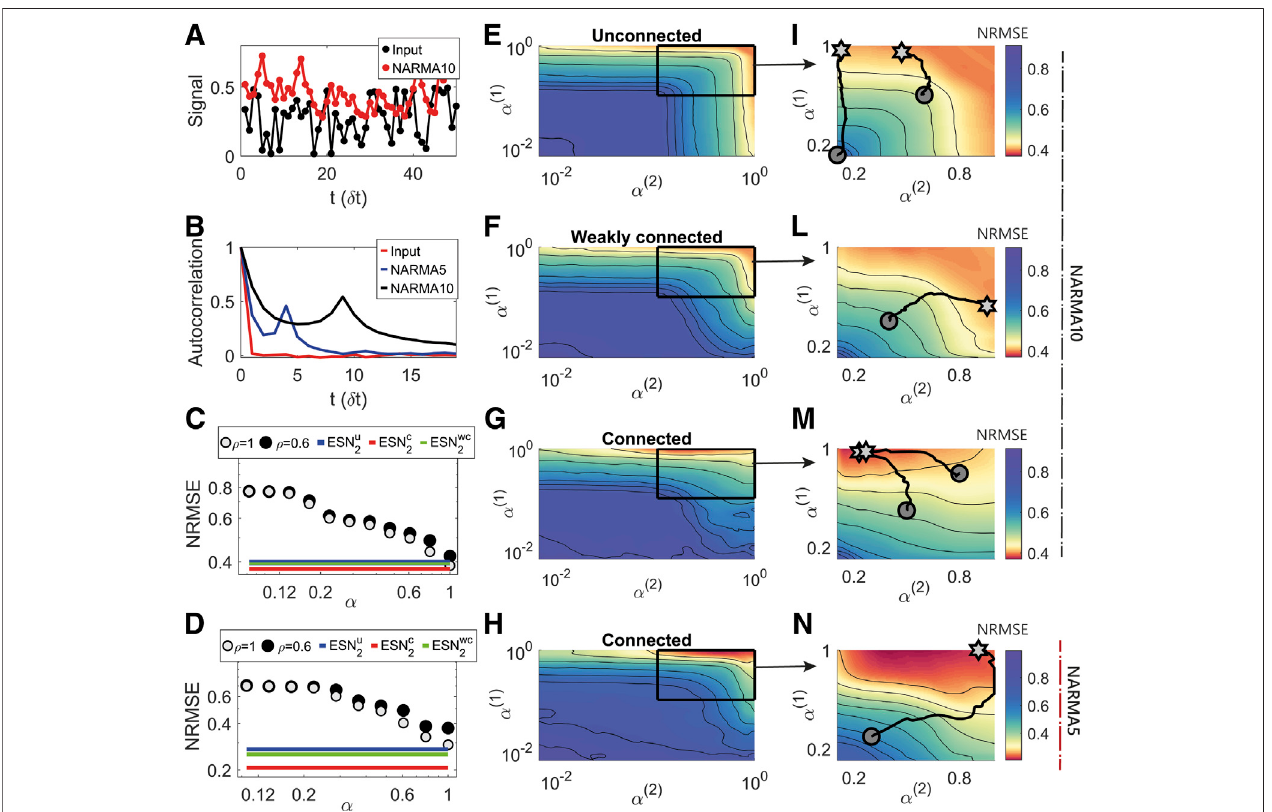
FIGURE 3 | Performance of single or hierarchical ESNs on the NARMA10 and NARMA5 task. (A) : Example input signal (black) and desired output (red) for the NARMA10 task. (B) : The auto-correlation function of the (black) input (red) NARMA10 and (blue) NARMA5 desired output signals, showing a second peak at about 9 delay steps for the NARMA10 and 4 for the NARMA5. (C) : The NRMSE for a single ESN for with ρ (cid:2) 1 . 0 and 0.63 over a range of α . The NRMSE is lower for ρ ≈ 1 and α (cid:2) 1.Thesolidlines showtheminimumNRMSEfortheunconnected(blueline)and connected(redline);fortheunconnectedcase theminimumNRMSEissimilar to the single ESN while the connected case has a smaller NRMSE by about 10%. (D) : Average NRMSE of a single ESN for various α compared to the hierarchical ESNs fortheNARMA5task. (E – K): TheaverageNRMSE surfaceusingahierarchical ESN computed forvaryingtheleakage rates α ( k ) ofboththereservoircomponents for (E) and (I) (no coupling, ρ ( 21 ) (cid:2) 0), (F) and (J) (weak coupling, ρ ( 21 ) (cid:2) 0 . 1), and (G) and (K) (strong coupling, ρ ( 21 ) (cid:2) 1). Panels ( I-L ) show a close up in region for the range α ( k ) (cid:2) [ 0 . 1 , 1 ] tohighlightthechangingbehaviors.Thelinesonthesepanelsshowthetrajectoryofthe α ( k ) valuestrained directlyusingtheonlinemethod.Foreach case of the coupling the online learning trends toward the approximate error minimum. (H) shows the NRMSE surface for the NARMA5 task using a strongly connected hierarchical ESN, with (N) again showing a zoom of the α (cid:2) [ 0 . 1 , 1 ] region. The region of best performance is with α ( 2 ) ≈ 0 . 5 which matches the shorter timescale demonstrated in the auto-correlation in (B)